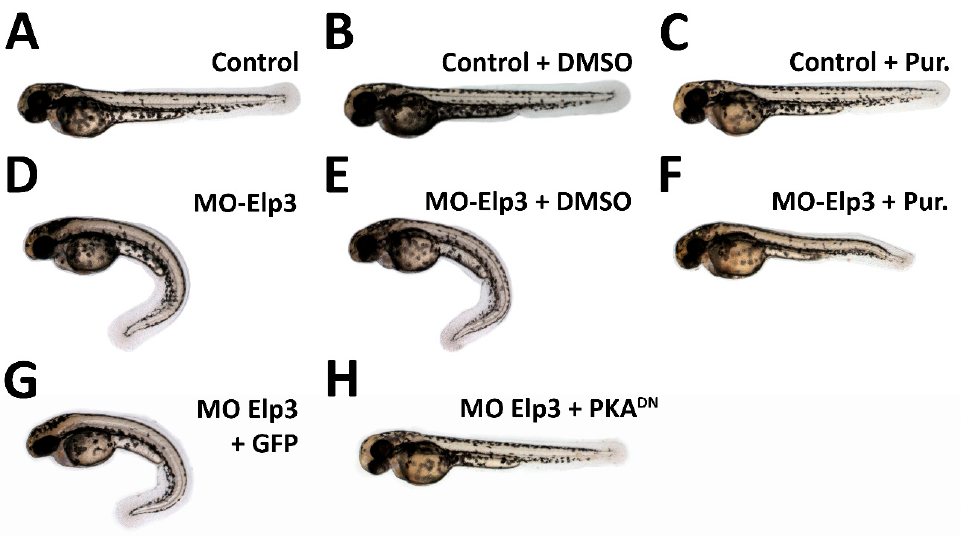
Figure 5. Morphant phenotype is rescued by sonic hedgehog pathway activation. Images of 2dpf larvae of ( A ) Control, ( B ) Control + 0.1% DMSO ( C ) Control + Pur 10 µ M, ( D ) MO-Elp3 injected, ( E ) larvae of ( A ) Control, ( B ) Control + 0.1% DMSO ( C ) Control + Pur 10 µM, ( D ) MO-Elp3 injected, ( E ) MO-Elp3 + 0.1% DMSO and ( F ) MO-Elp3 + Pur 10 µ M. ( G ) MO Elp3 + GFP mRNA and ( H ) MO Elp3 MO-Elp3 + 0.1% DMSO and ( F ) MO-Elp3 + Pur 10 µM. ( G ) MO Elp3 + GFP mRNA and ( H ) MO Elp3 + PKA DN mRNA. Images are representative of four independent experiments.